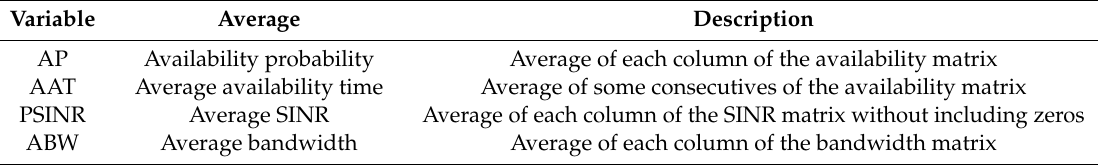
Figure 11. Input and output variable of the multi-criteria decision-making (MCDM) module. Table 9. Vectors for multi-criteria analysis, adapted from [15].